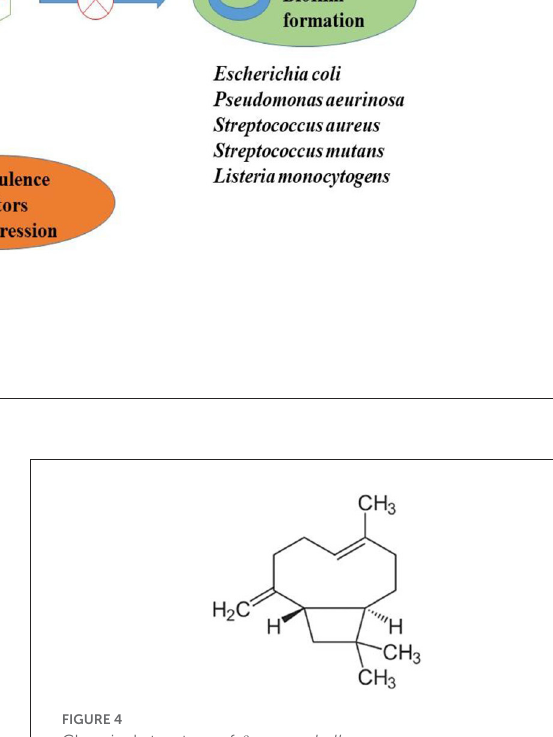
FIGURE4 Chemical structure of β -caryophyllene